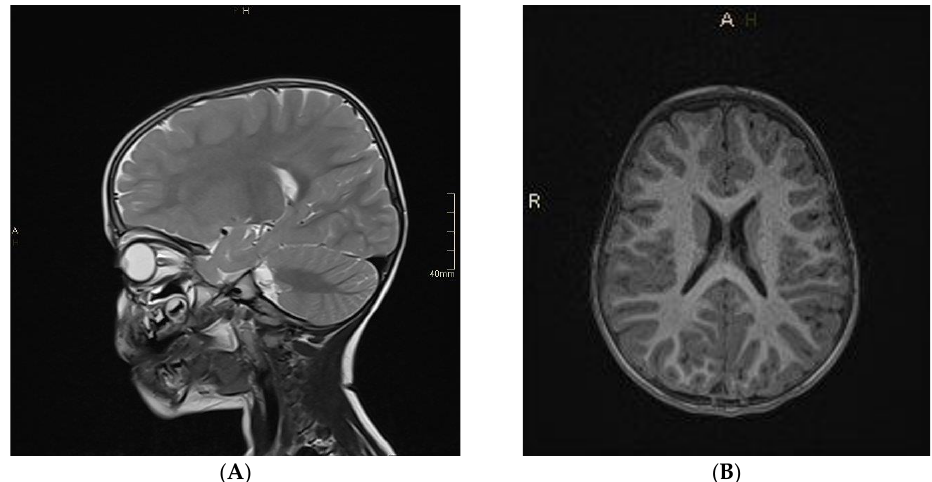
Figure 2. Head MR imaging (T2 − weighted ( A ) and T1 − weighted ( B ) images) of 2.5 − year − old boy with a lack of eye contact and abnormal eye movements. The MR examination was normal. Source: own study.